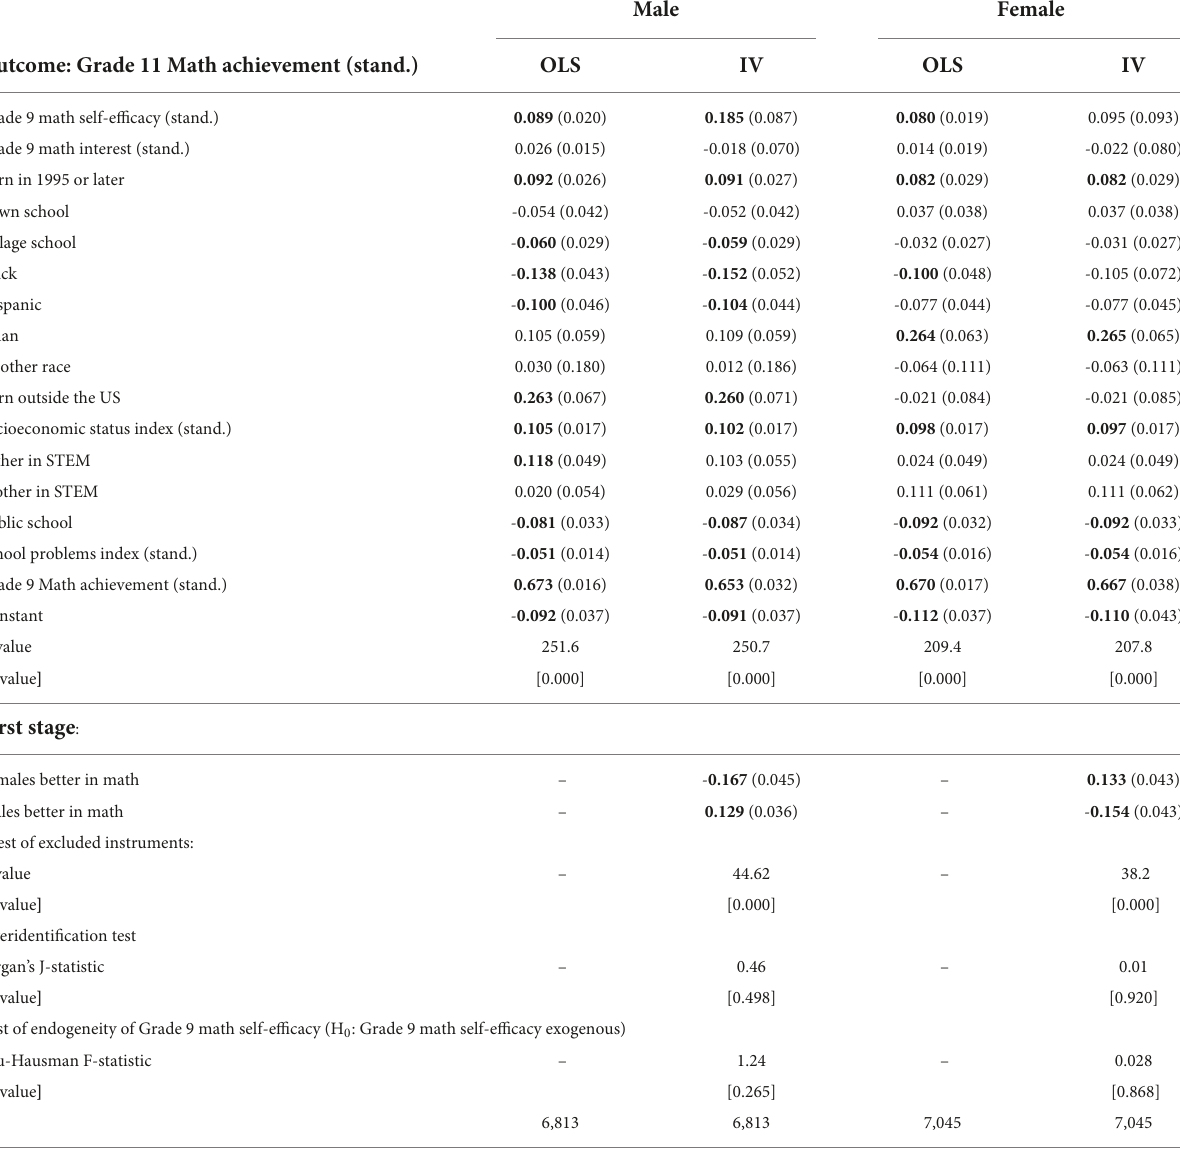
TABLE 2 Effect of earlier mathematics self-efficacy on later mathematics achievement by gender. Male Female Outcome: Grade 11 Math achievement (stand.) OLS IV